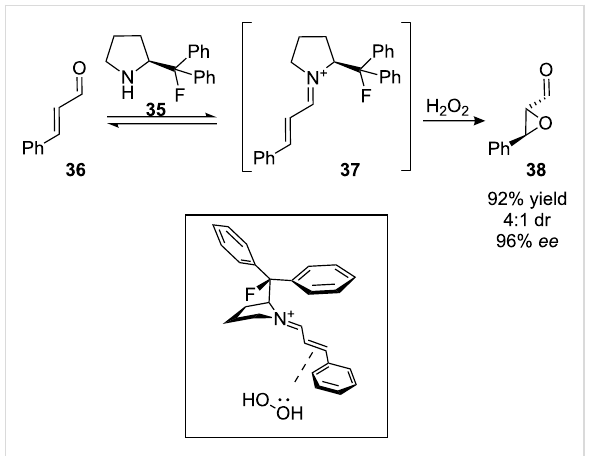
Figure 9: Asymmetric epoxidation reaction catalysed by pyrrolidine 35 . Inset: the geometry of the activated iminium ion intermediate 37 is stabilised by a gauche F–C–C–N + alignment.